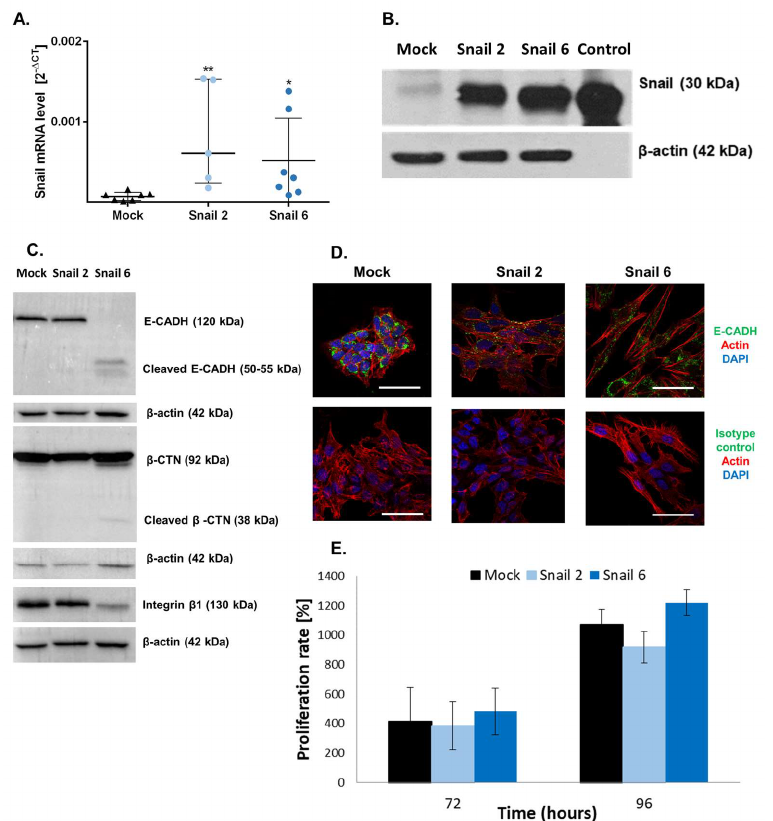
Figure 1. Characterization of Snail-MC38 stable clones. ( A ) Relative Snail mRNA expression in pcDNA-MC38 (Mock) and Snail-MC38 clones (clone #2 and #6: Snail 2 and Snail 6, respectively). Snail mRNA levels were normalized to GAPDH and EEF1A1 . Results are shown as median with interquartile range; * p ≤ 0.05 and ** p ≤ 0.01, n = 7. ( B ) Representative Western blot analysis of Snail protein expression in Mock and Snail-MC38 clones. Control: recombinant human Snail. ( C ) Western blot analysis of E-cadherin (E-CADH), β-catenin (β-CTN), integrin β1, and β-actin in Mock and in Snail-overexpressing MC38 cells. ( D ) Distribution of E-CADH and actin in Mock and Snail-overexpressing MC38 cells (representative images, scale bar: 50 µ m). ( E ) Cell proliferation rate of Mock- and Snail-MC38 clones at 72 and 96 h. Data are shown as mean ± SEM. Uncropped gels from Figure 1B,C and densitometry of Western blot results are shown in supplementary Figure S1B and Figure S1C,